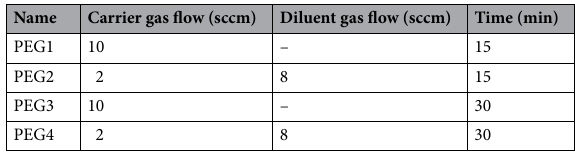
Table 1. Parameters of the plasma polymerization